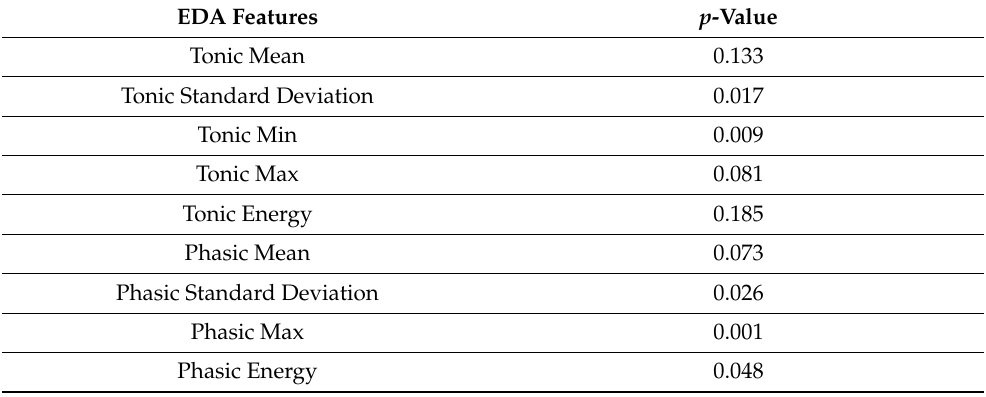
Table 8. Wilcoxon signed-rank test results for